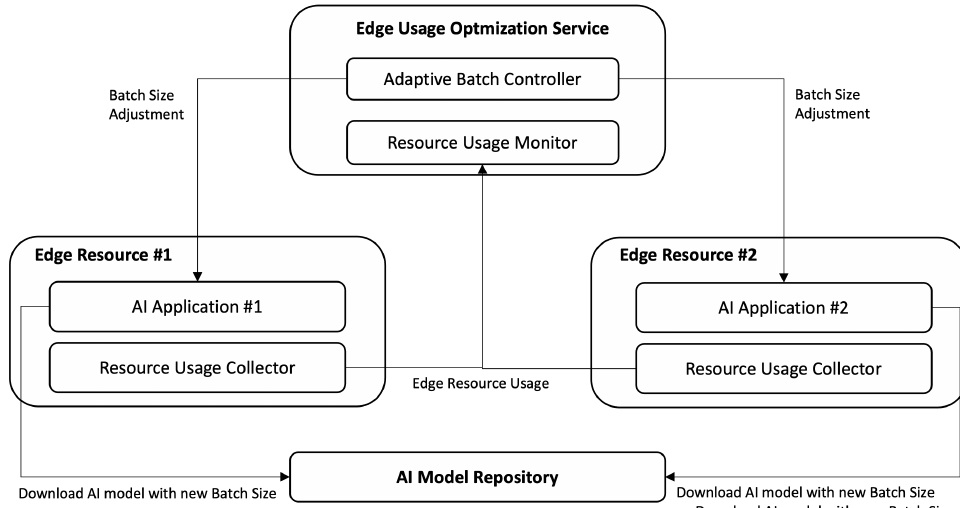
Figure 4. Structure of the proposed